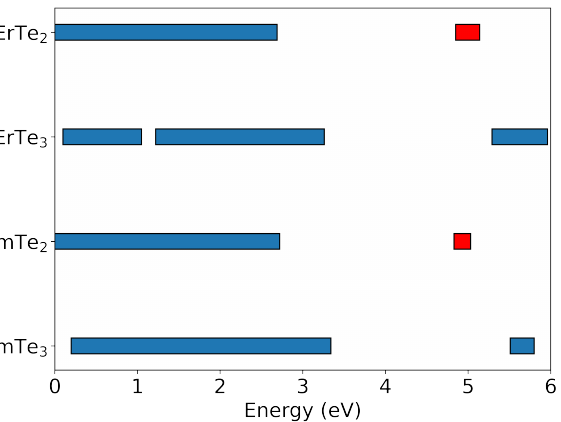
Figure 8. The energy ranges in which RTe crystals exhibit hyperbolic dispersion. The hyperbolic behavior of type 1 is shown in blue and type 2 in